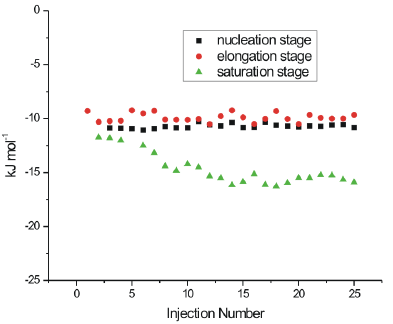
Figure 9. ITC profiles for the titrations of lysozyme solution at different stages with 0.25 M TMAO at 25 6